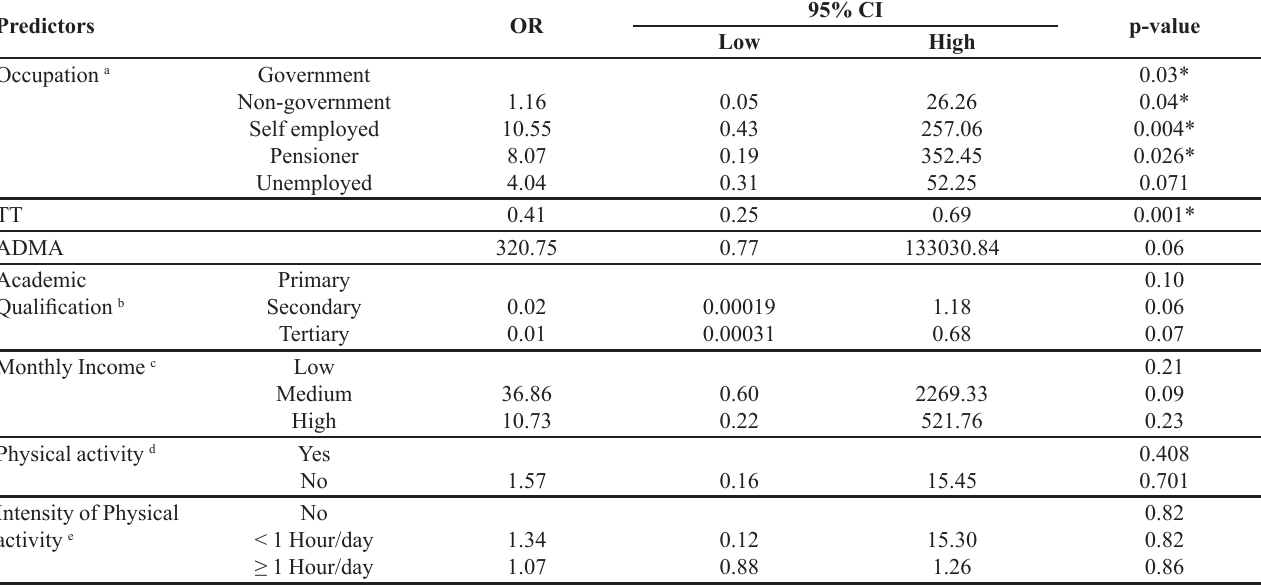
TABLE III - Predictors of Severity of ED (Binary Logistic Regression – Factors Associated with Severity of ED) Predictors